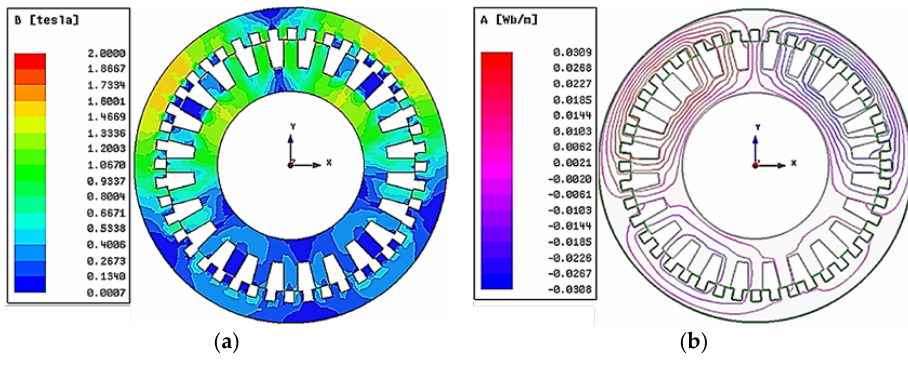
Figure 5. ( a ) Induced back EMF for 5 A DC field current at 300 rpm and ( b ) electromagnetic torque.